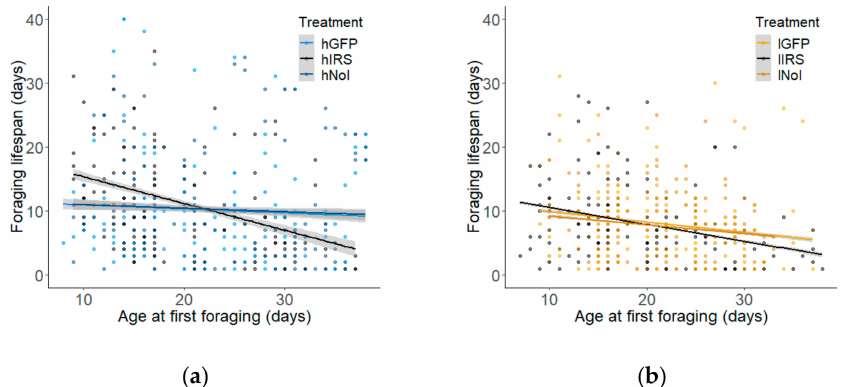
Figure 8. Relationship between pre- and post-foraging lifespan components predicted via the general linear model. ( a ) irs knockdown (hIRS) influences the relationship between the pre- and post-foraging components of lifespan in the high strain by reducing foraging lifespan more than the injected control (hGFP) group for each day that foraging onset was delayed (glmm: 0.39 ± 0.11 s.e., χ 2 = 14,31, p = 0.0008, n = 444). ( b ) The interaction between age of first foraging and treatment was not significant in the low strain (glmm: 0.08 ± 0.101 s.e., χ 2 = 1.12, p = 0.573, n = 447). Fitted lines are ± 95% confidence